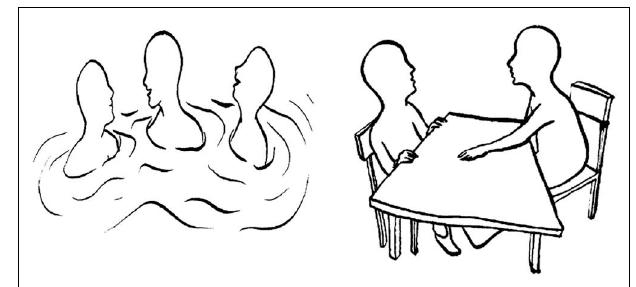
FIGURE 1 |Two example pictures from the operant motives